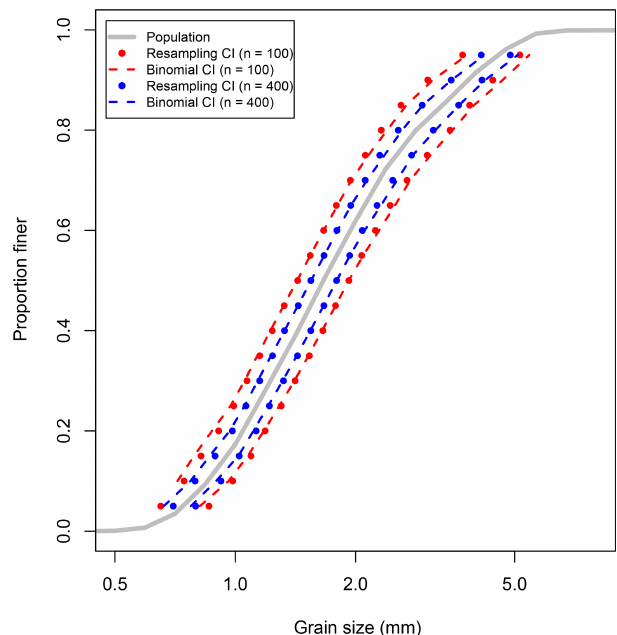
Figure 6. Comparing calculated resampling grain size confidence intervals to predicted intervals using the binomial approach. The grain size confidence intervals for samples of 100 stones are shown in red and those for samples of 400 stones are shown in blue.